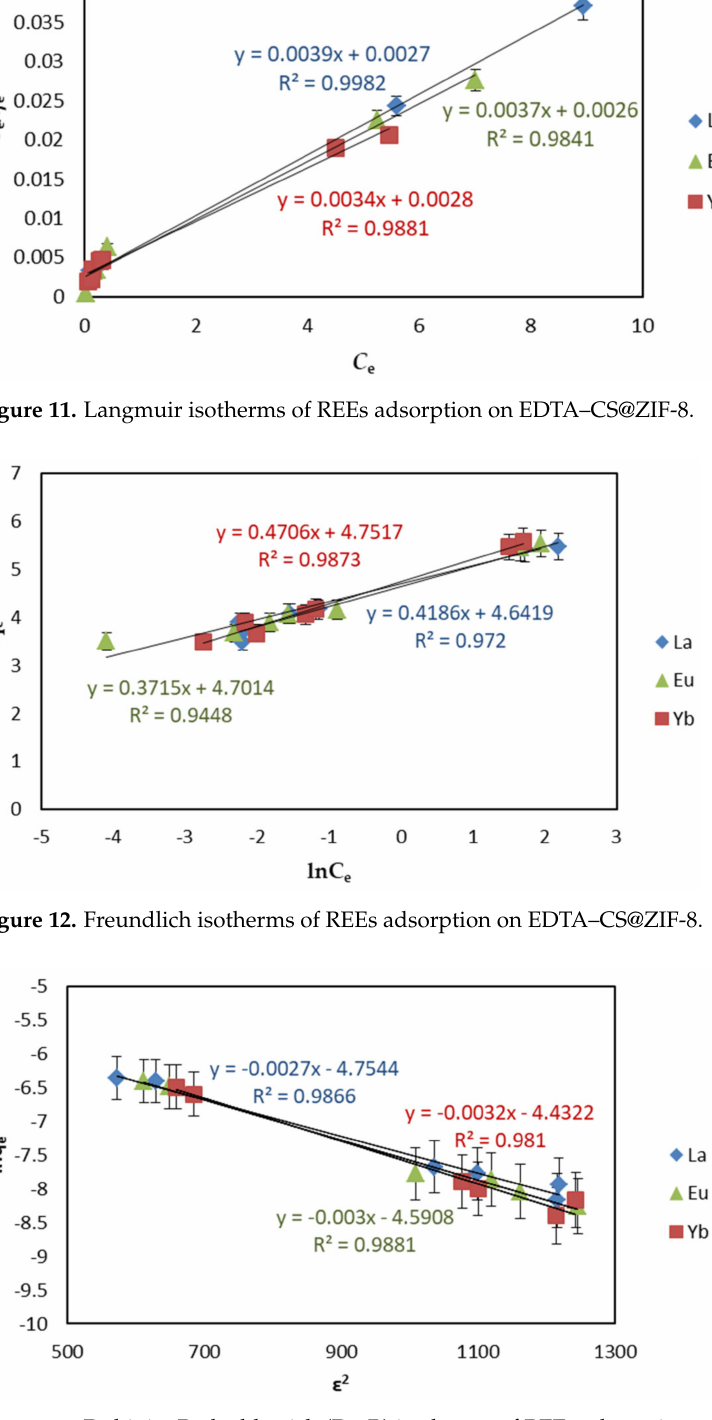
Figure 13. Dubinin–Radushkevich (D − R) isotherms of REEs adsorption on